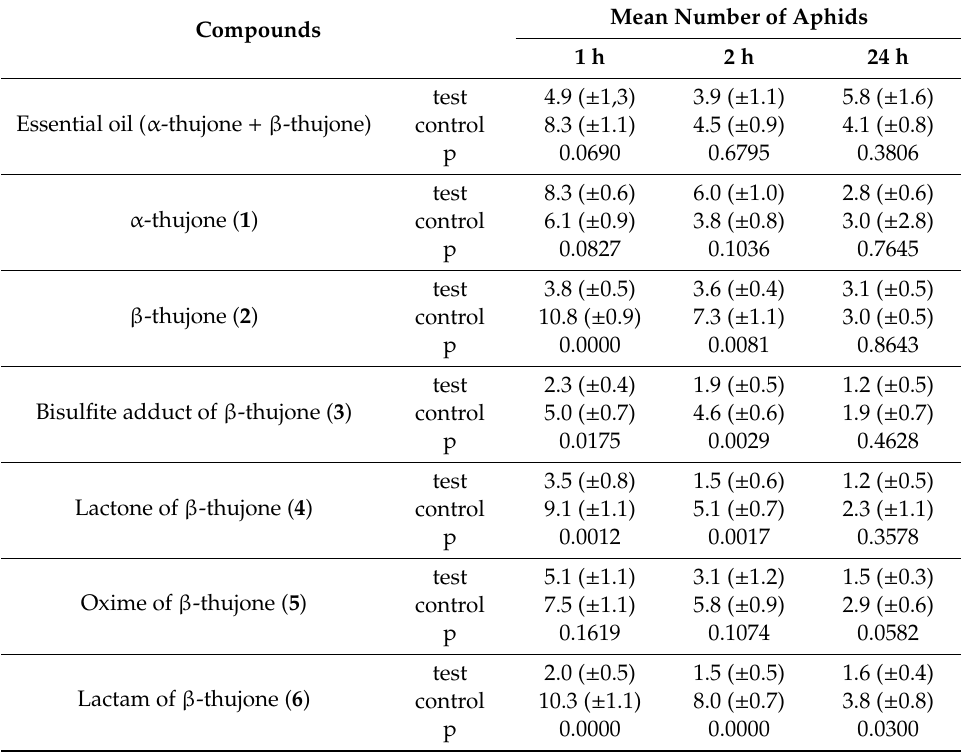
Table 1. E ff ect of T. occidentalis essential oil, (-)- α -thujone ( 1 ), ( + )- β -thujone ( 2 ) and β -thujone ( 2 ) derivatives bisulfite adduct ( 3 ), lactone ( 4 ), oxime ( 5 ), lactam ( 6 ), on settling of Myzus persicae on Brassica rapa subsp. pekinensis